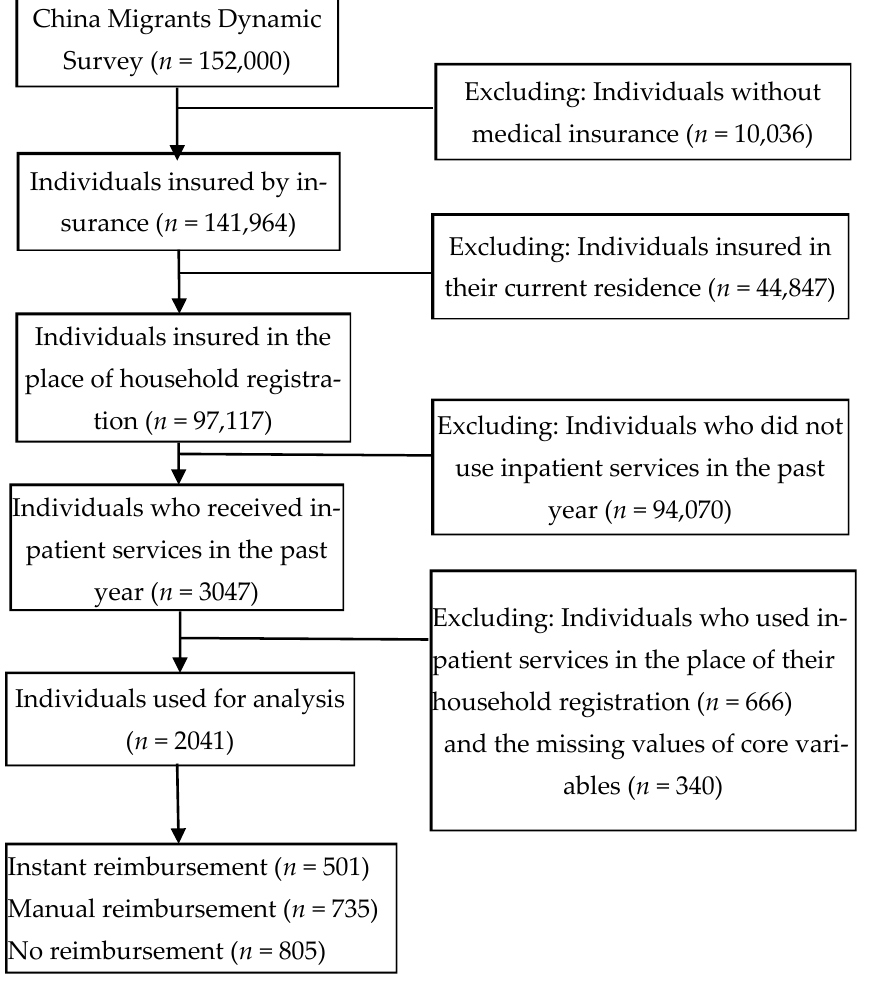
Figure 2. Flowchart of samples screening.